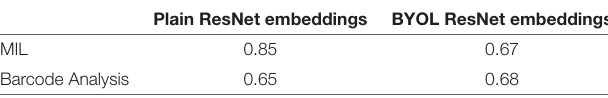
TABLE 2 | The embedding is important for the downstream classifiers.